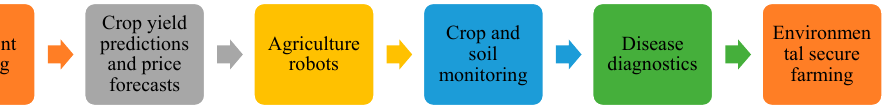
Figure 2. Role of precision agriculture in sustainable agriculture production.